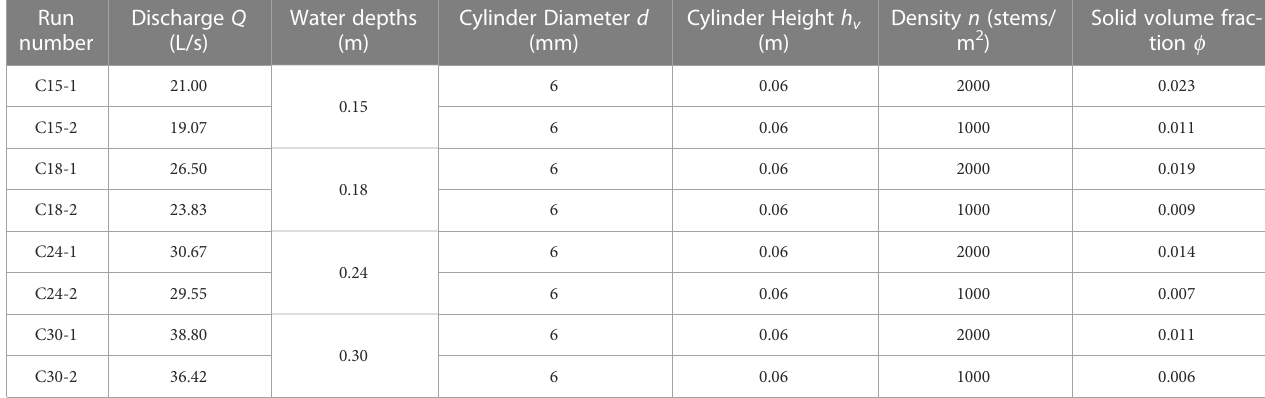
TABLE 3 Hydrodynamic conditions and cylinder con fi gurations in experiments conducted by Lu